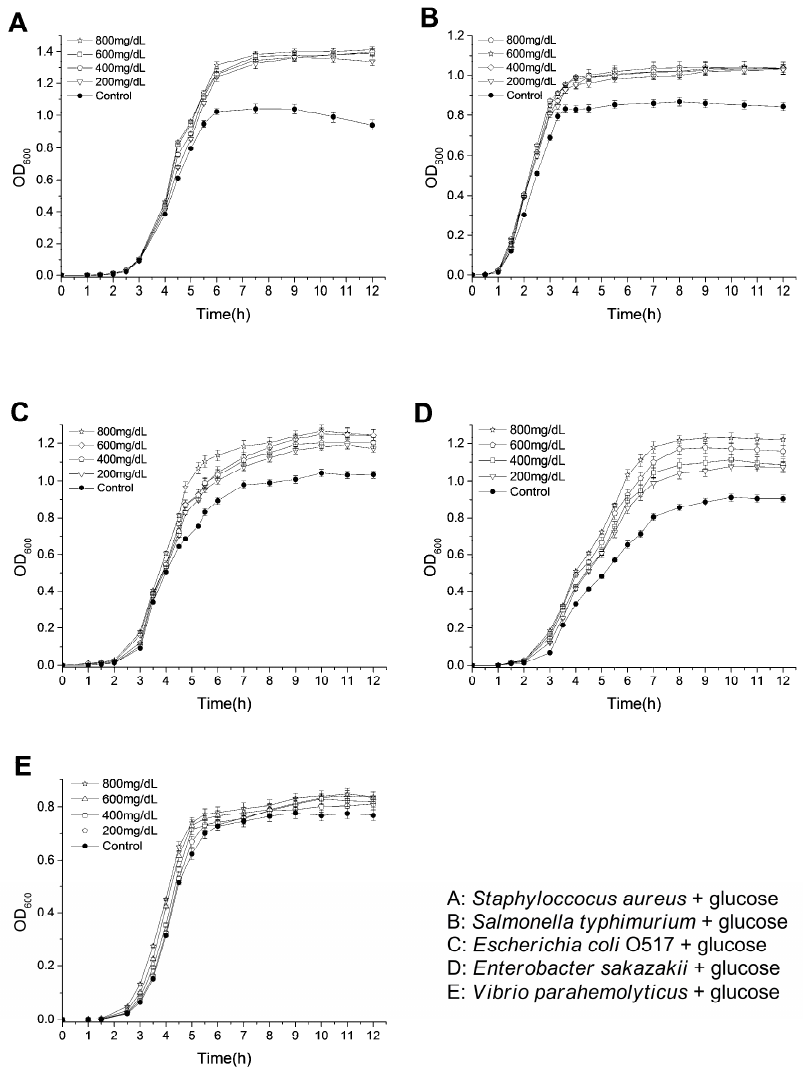
Figure 1. Effects of glucose on the growth of tested bacteria.